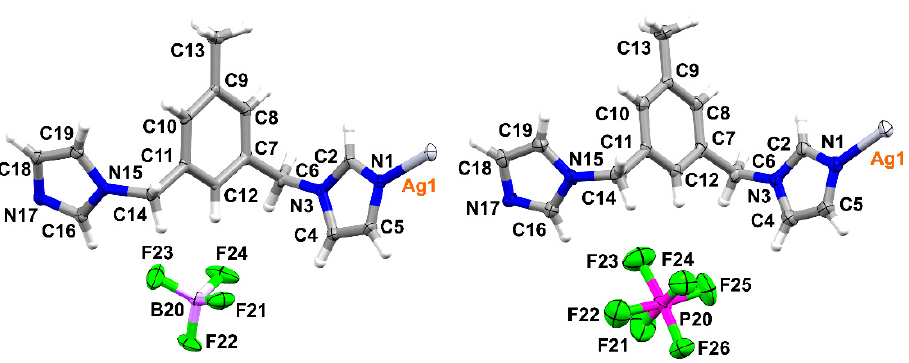
Figure 2. Representation of the asymmetric unit in 1 ( left ) and 2 ( right ); atomic displacement plots are shown with 50% probability.